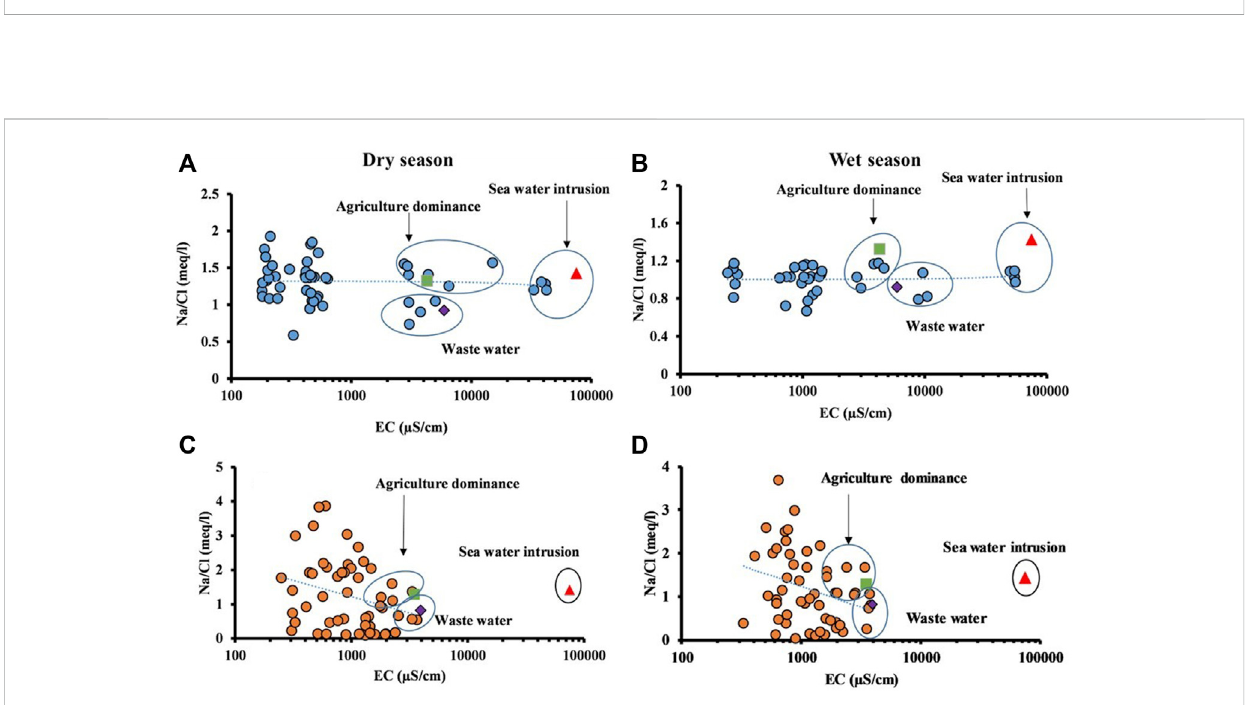
FIGURE 10 Relationship between EC and Na/Cl in (A) river water — dry season, (B) river water — wet season, (C) groundwater — dry season, and (D) groundwater — wet